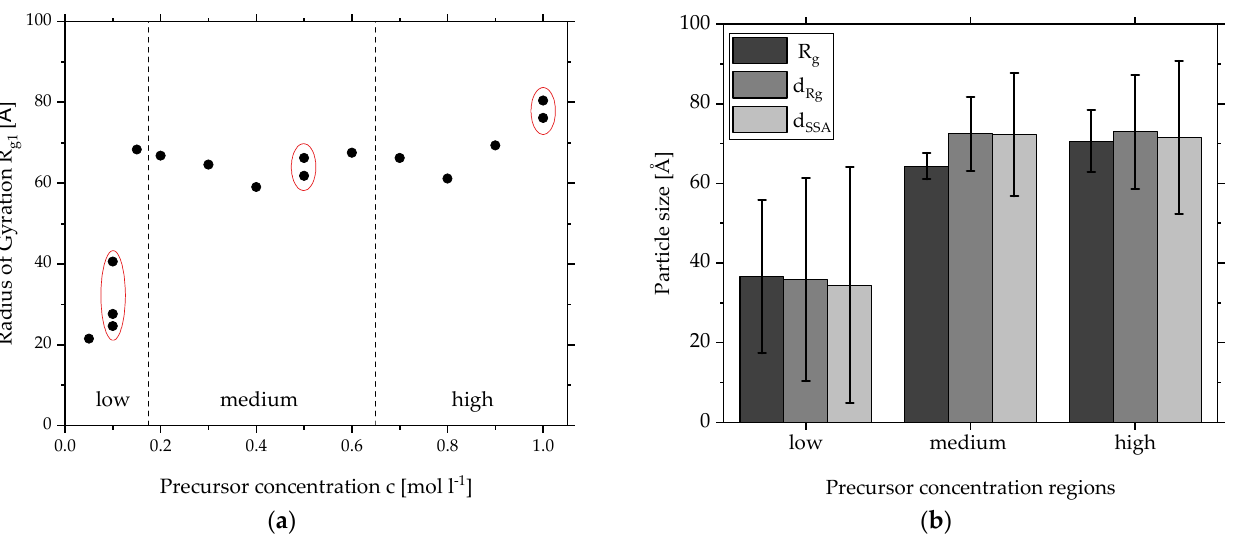
Figure 2. ( a ) Radii of gyration from SAXS data of primary particle level made by SFS from different precursor concentrations grouped in regions: low ( c = 0.0–0.15 mol L − 1 ), medium ( c = 0.2–0.6 mol L − 1 ) and high ( c = 0.7–1.0 mol L − 1 ). ( b ) Averaged primary particle size for each region of precursor concentration calculated from SAXS data: radius of gyration, diameter based on radius of gyration, diameter based on specific surface